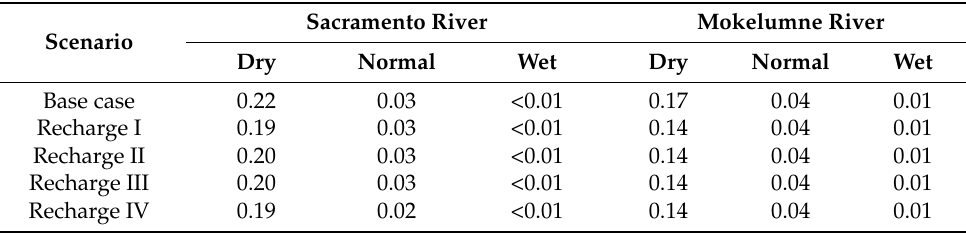
Table 9. Annual average upper bound shadow values (USD/m 3 ) at Mokelumne and Sacramento Rivers where minimum instream flow needs to be